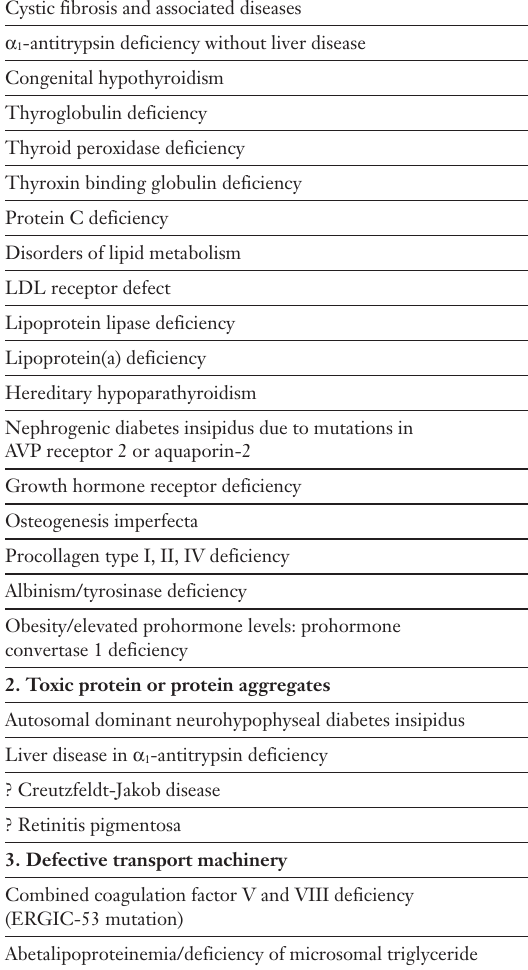
1. Lack of protein due to ER retention Endoplasmic reticu- Cystic fibrosis and associated diseases lum storage a 1 -antitrypsin deficiency without liver disease